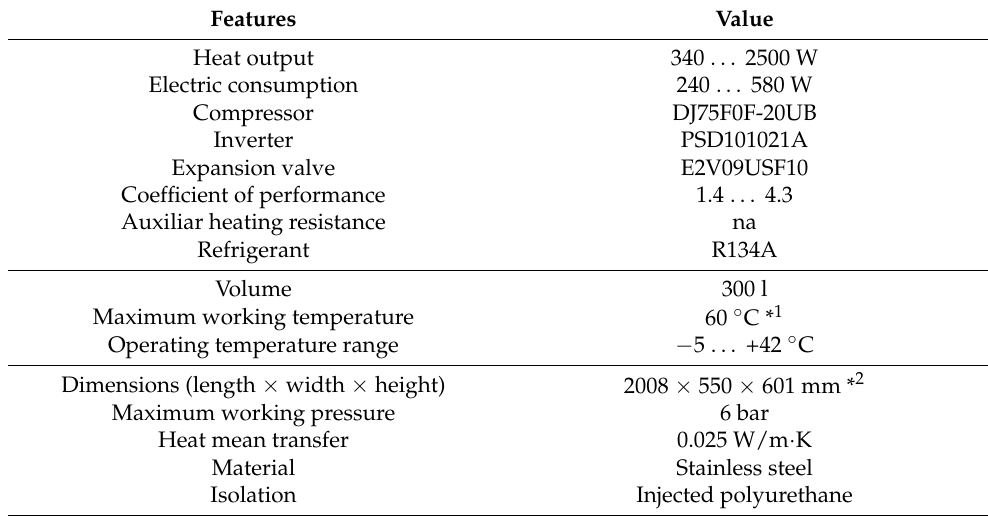
Table 3. HP and TES main